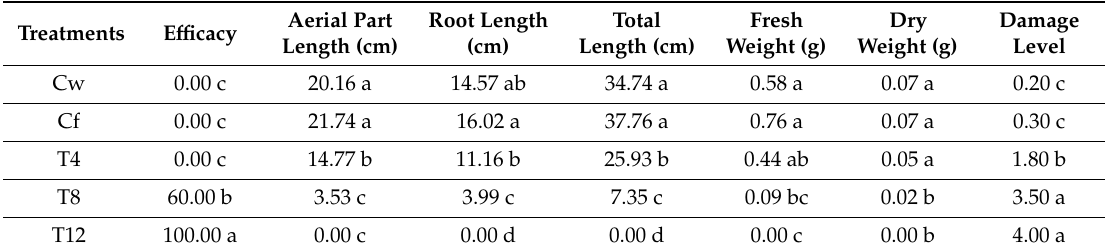
Table 9. E ffi cacy, e ff ects on several plant traits (aerial part, root and total length, fresh and dry weight), and damage level of TC4 EO at di ff erent application doses on A. fatua . T4, T8, T12: 4, 8, 12 µ L / mL EO; Cw: water control; Cf: Fitoil